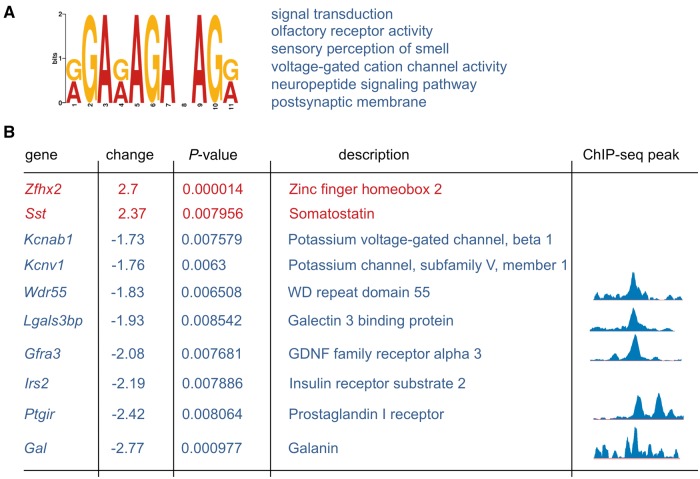
Potential transcriptional targets of ZFHX2. (A) The consensus AG-rich motif derived from promoter regions of deregulated genes in the microarray screen. The motif has been constructed from five common motifs highly represented in 1000-bp upstream regions (Supplementary Fig. 6). (B) The top six GO terms for genes that contain the AG-rich motif. For more information see Supplementary Table 4. The genes with the biggest change in their expression levels (P < 0.01). Zfhx2 expression level is shown as a positive control as it is expected to rise after introducing extra copies of the Zfhx2mut gene. Some of these genes have shown an enrichment of ZFHX2 binding at their regulatory upstream regions (as indicated in right column) as analysed by ChIP-seq analysis.